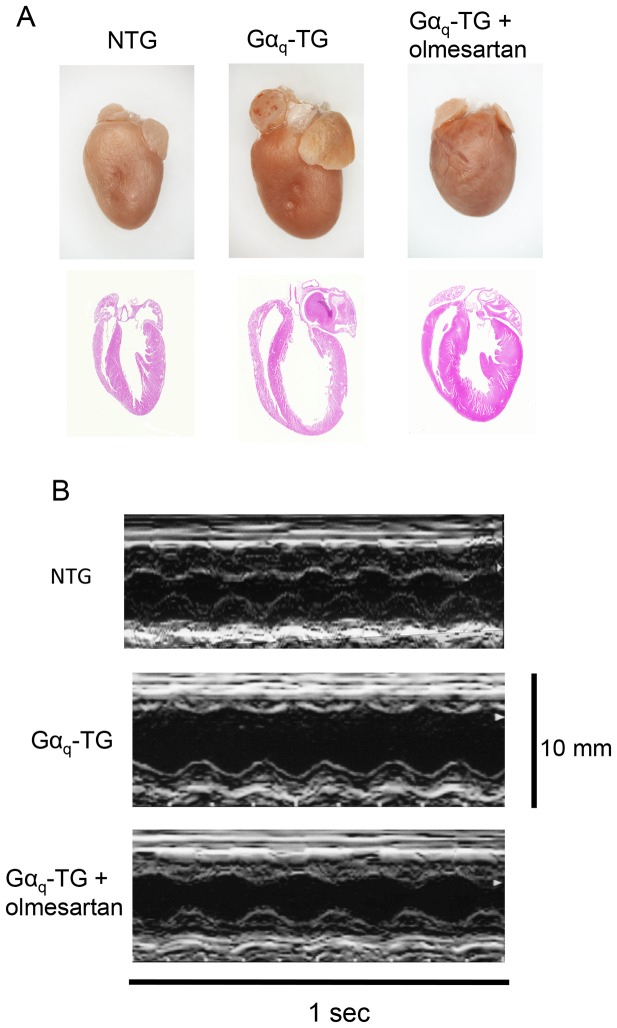
Effects of olmesartan on cardiac morphology and on the left ventricular contractile function.Panel A: Gross examination of a heart and its four-chamber view histology stained with hematoxylin/eosin in NTG, Gαq-TG, and Gαq-TG+olmesartan mouse hearts. The four-chamber view histology revealed all chambers to be dilated in the vehicle-treated Gαq-TG heart compared with those in NTG and olmesartan-treated Gαq-TG hearts. Original magnification: 1.25×. Mice at the age of 32 weeks were used. Panel B: Representative M-mode echocardiograms of NTG, Gαq-TG, and Gαq-TG+olmesartan mice at the age of 32 weeks.